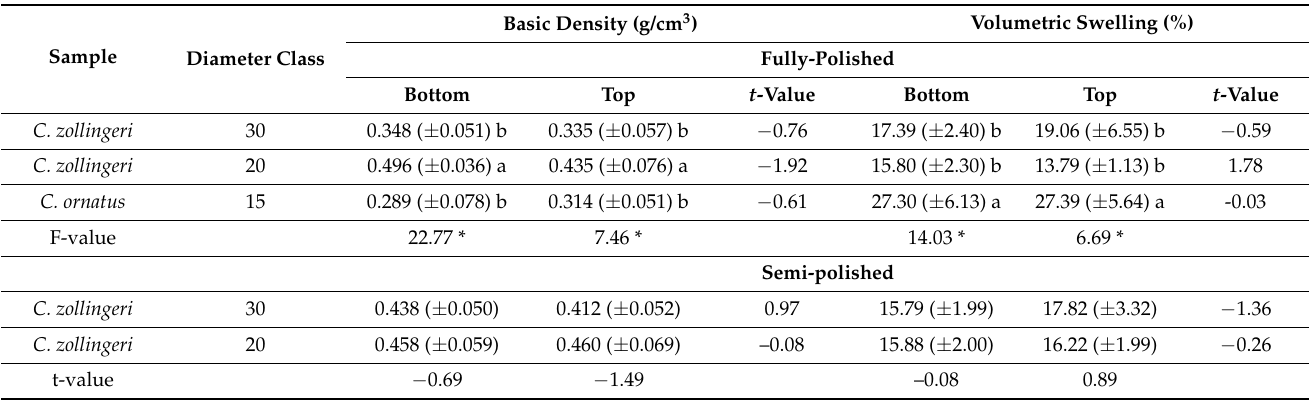
Table 3. Mean basic density and volumetric swelling values of semi- and fully polished rattan samples in different diameter classes. Mean values ( ± standard deviations) of n = 8 per sample